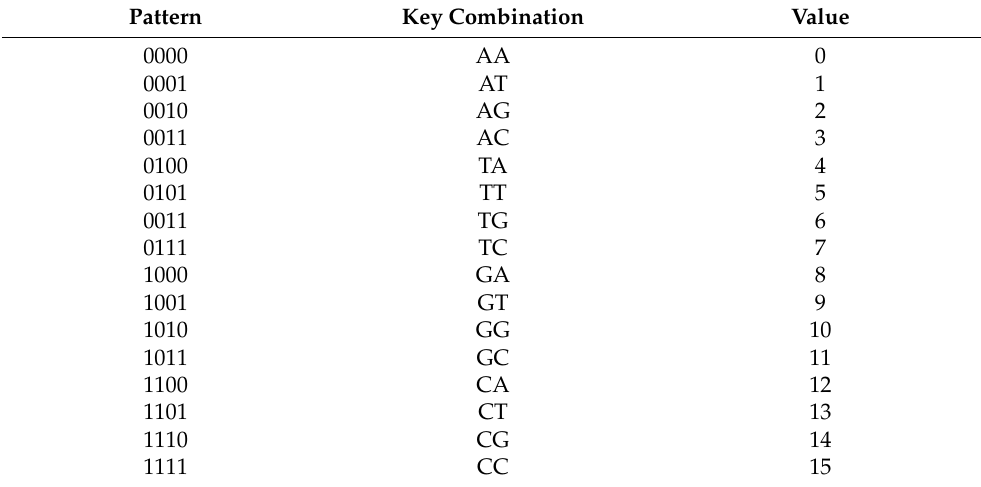
Table 1. DNA Key Combination.